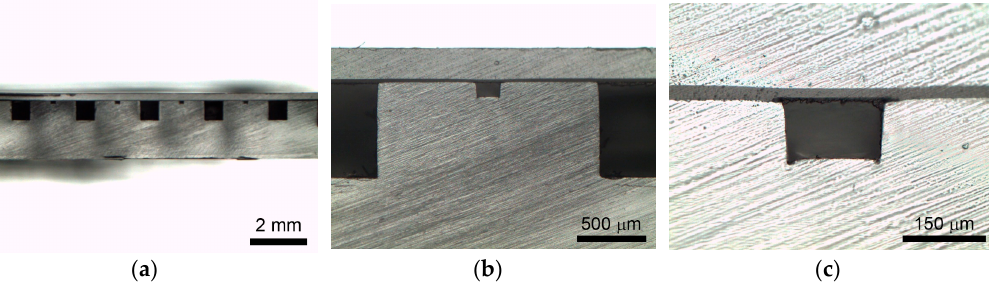
Figure 4. ( a ) Cross-sectional micrograph of the PMMA–PC microchip. ( b ) Close-up view of Figure 4a. ( c ) Closed-up view of the cross-sectional microchannel of Figure 4b.